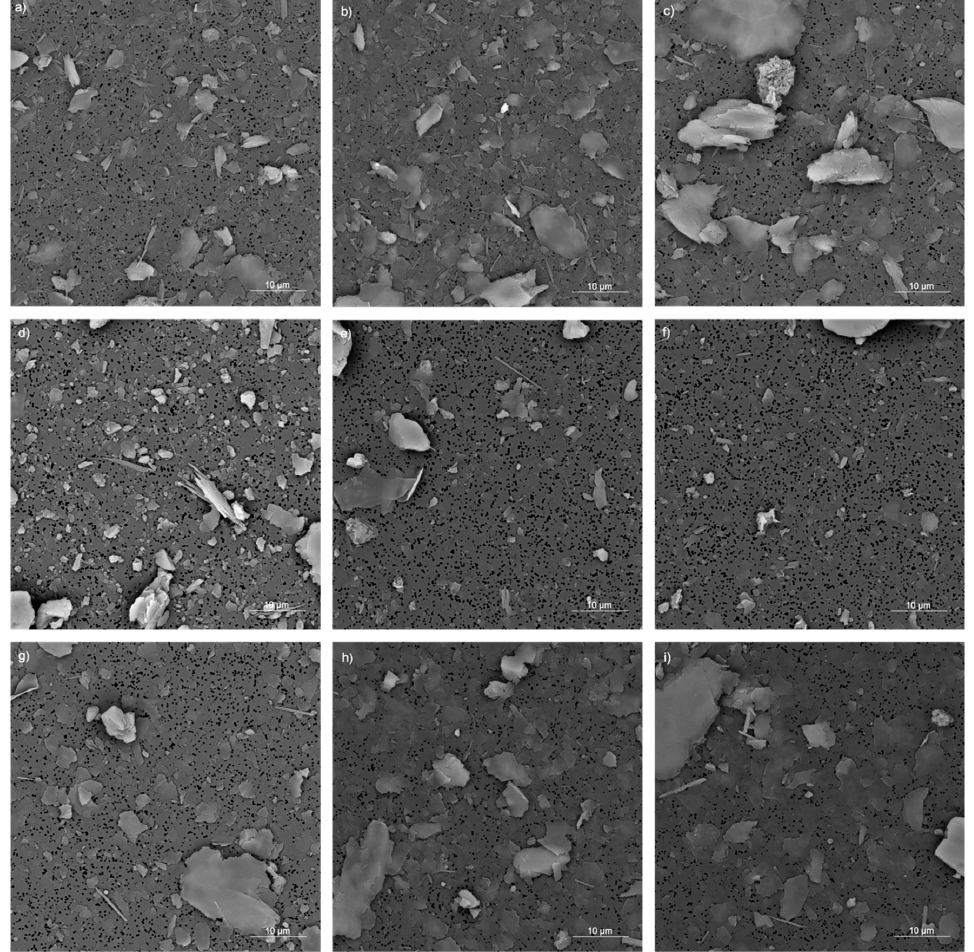
Figure 9. SEM microphotographs of fibers from ( a – c ) serpentinite; ( d – f ) debris; and ( g – i ) soil representative of 2 to 20 mm, 0.106 to 2 mm, and non-milled fractions (High Vacuum; 20 kV; magnification: 5000 × ; Detector: Back scattered electrons).